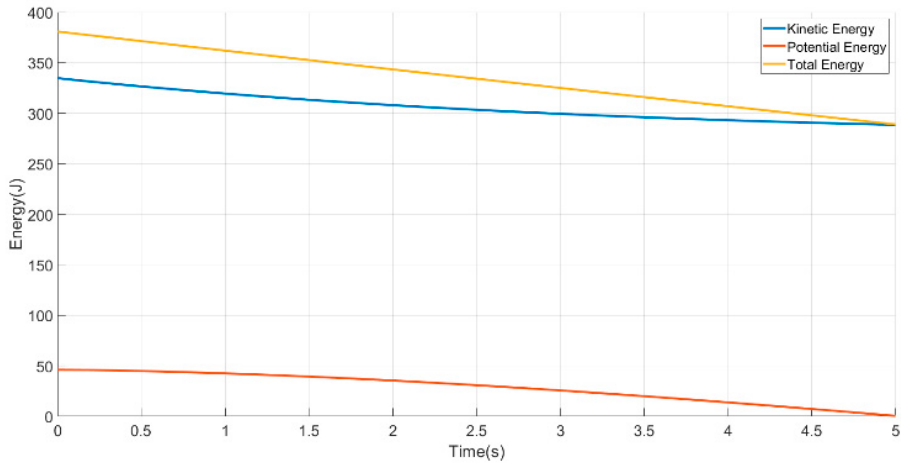
Figure 8. The detailed results for the energy.